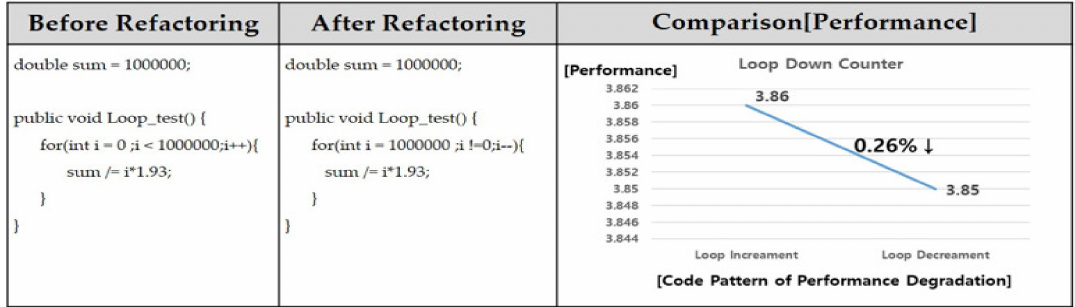
Figure 14. Before and after improving loop down counter.